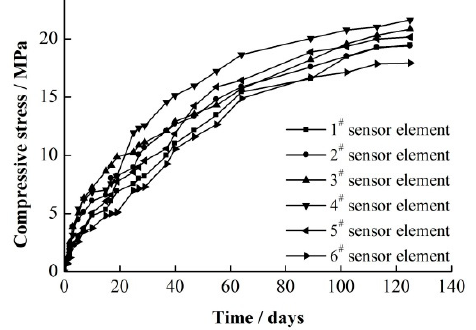
Figure 18. Comprehensive stress recovery curves for the PDS No. 11 coal mine. Table 7. In situ stresses under geodetic coordinates for the test points in the PDS No. 11 coal mine.